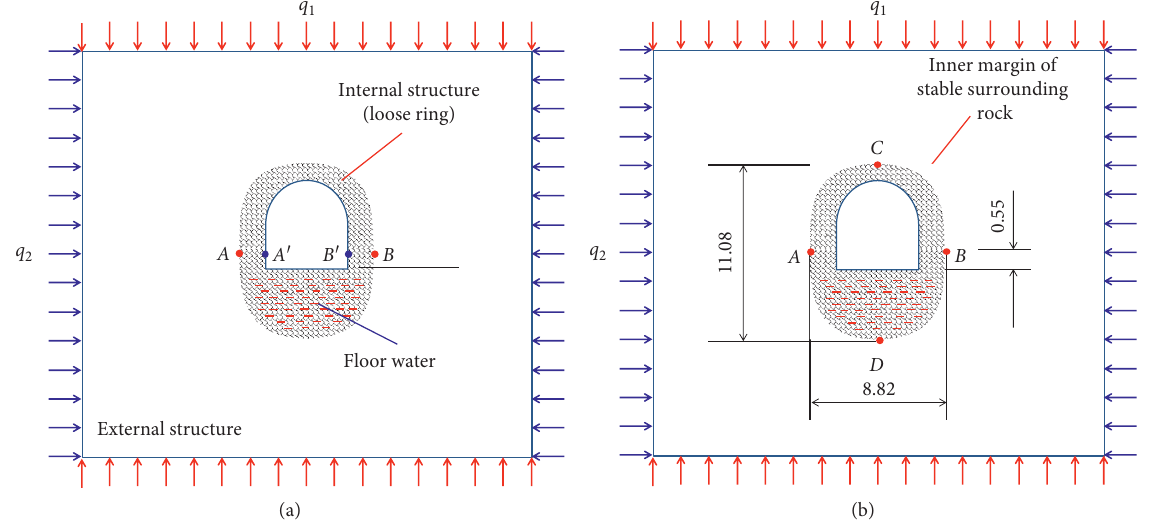
Figure 4: Stress analysis of the bearing structure in soft rock roadway (unit: m).